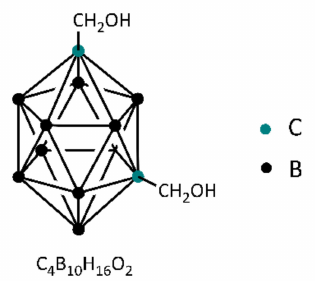
Figure 1. The structure of